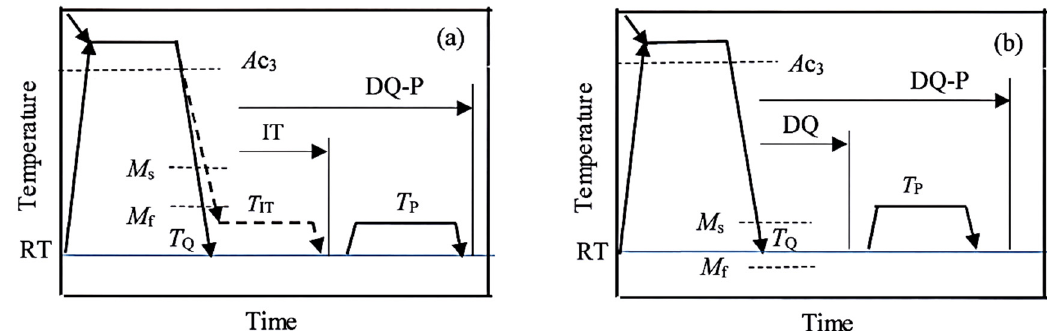
Figure 2. Heat treatment diagrams of ( a ) the isothermal transformation (IT) process below M f and direct quenching to room temperature (RT) followed by partitioning (DQ-P) process in a case of RT < M f [58–63] and ( b ) the DQ and DQ-P process in a case of RT > M f [67–69]. RT: room temperature, T IT : isothermal transformation temperature, T Q : quenching temperature, T P : partitioning temperature.